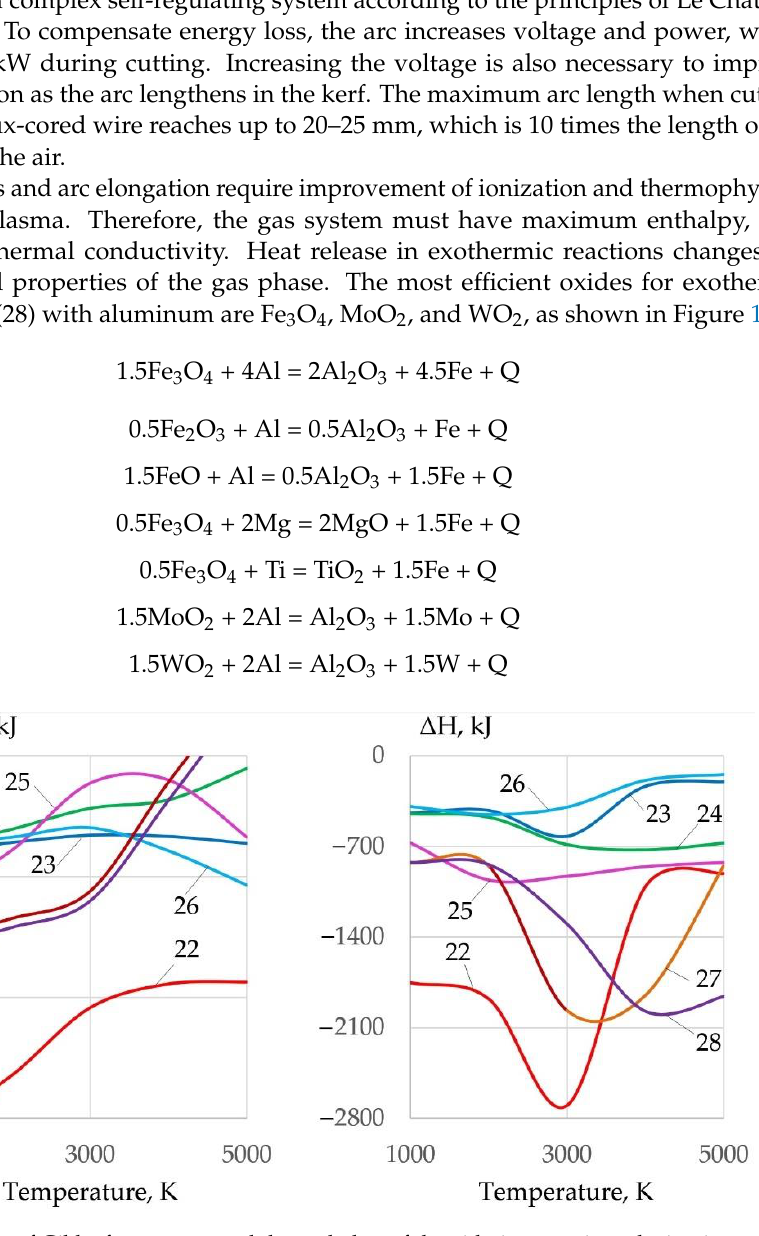
Figure 12. Change of Gibbs free energy and the enthalpy of deoxidation reactions during interaction of oxides with aluminum.